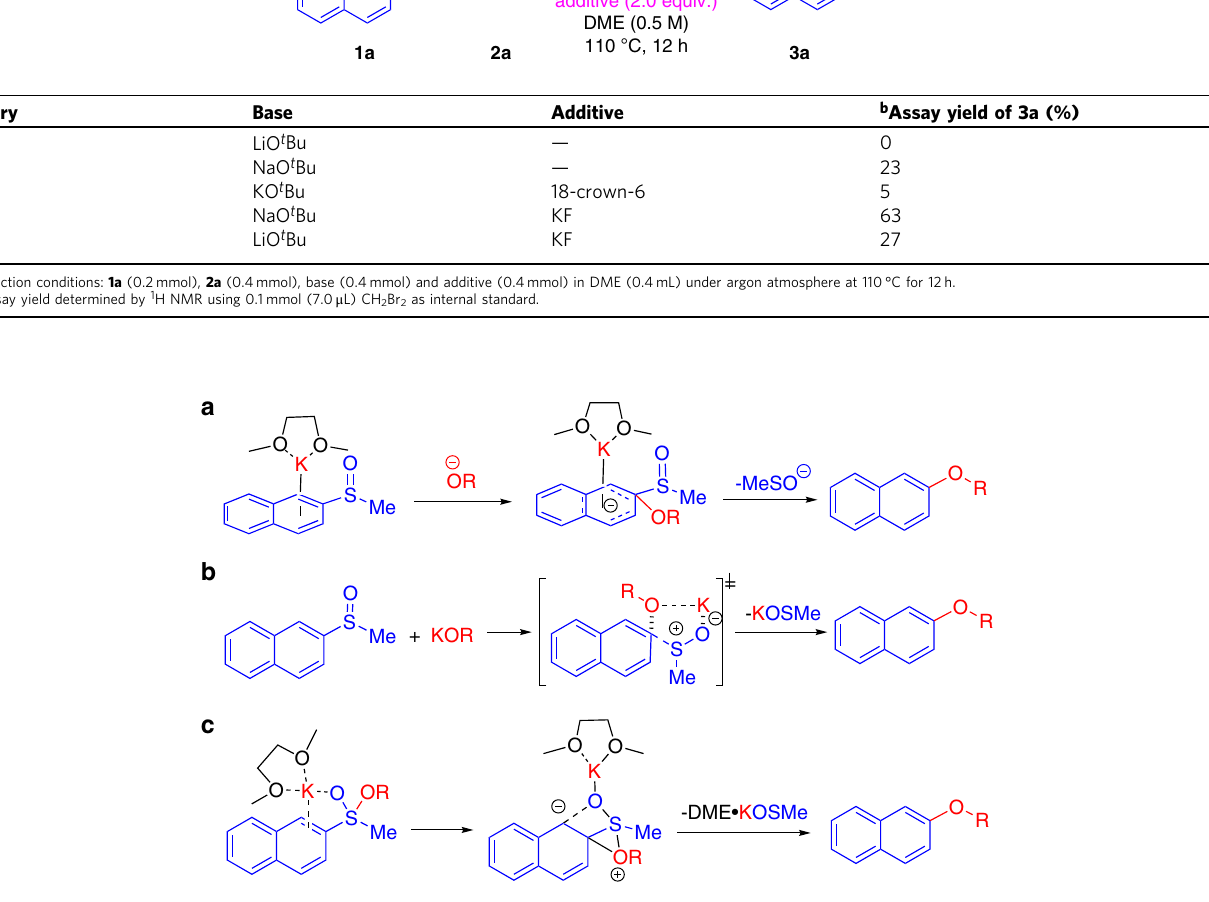
Fig. 5 Possible mechanistic pathways. The potassium assisted C – S bond activation of aryl methyl sulfoxides ( a - c